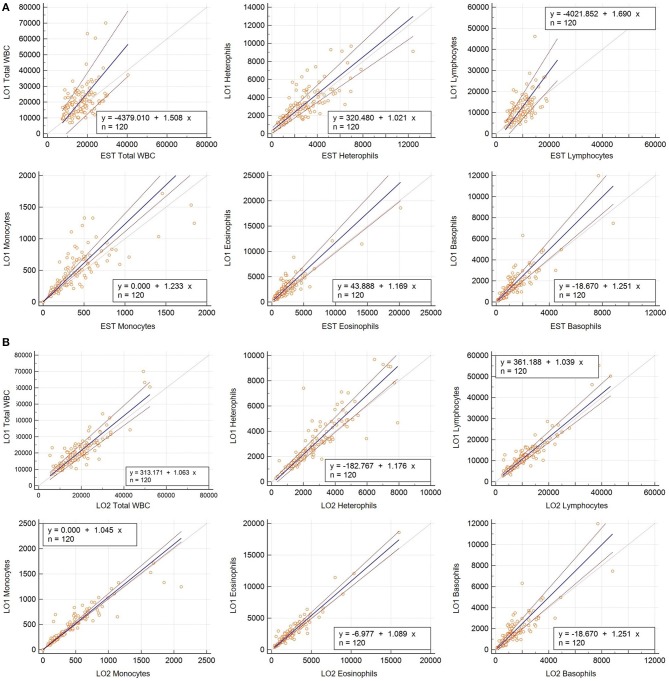
(A) Passing-Bablok regression analyses for hematology parameters determined using the Avian Leukopet method with the average of three replicates performed by a single observer (LO1) and the WBC estimation method (EST) in 120 free-living eastern box turtles (Terrapene carolina carolina). Solid lines depict linear regression lines and dashed lines depict the 95% confidence intervals around the linear regression line. (B) Passing-Bablok regression analyses for hematology parameters determined using the Avian Leukopet method from one observer (LO1) and a group of observers (LO2) in 120 free-living eastern box turtles (Terrapene carolina carolina). Solid lines depict linear regression lines and dashed lines depict the 95% confidence intervals around the linear regression line.